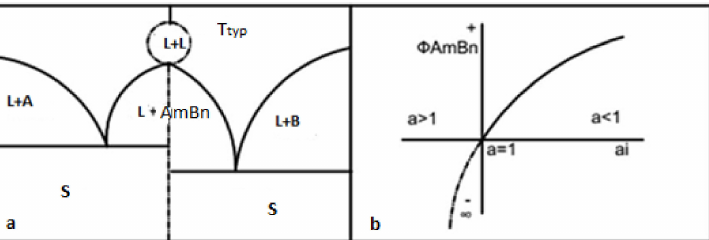
Figure 3. ( a ) The schematic display image of the phase diagram with formation of a complex chemical compound and the continuation of the liquidus line above the melting temperature on one and the other side of the A m B n compound; ( b ) the dependence diagram of the Bjerrum–Guggenheim coefficient near the melting point of the A m B n compound.